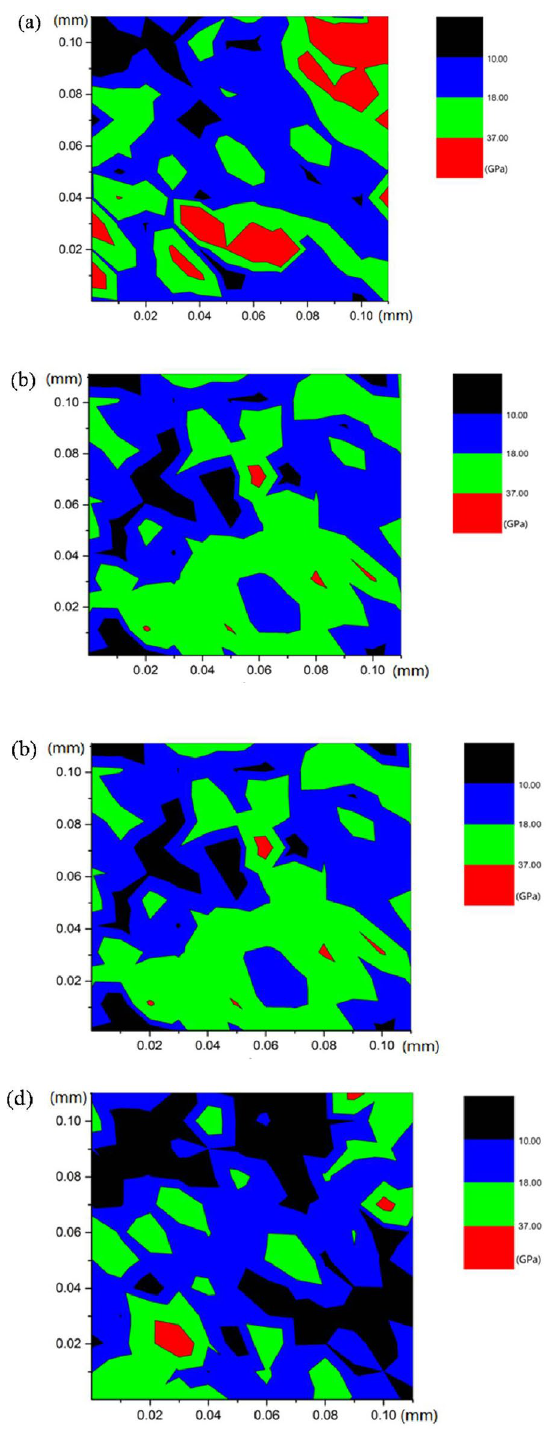
Figure 8. Contour map of nanoindentation results of mortar: ( a ) 0 cycle, ( b ) 300 cycles, ( c ) 700 cycles, ( d ) 1500